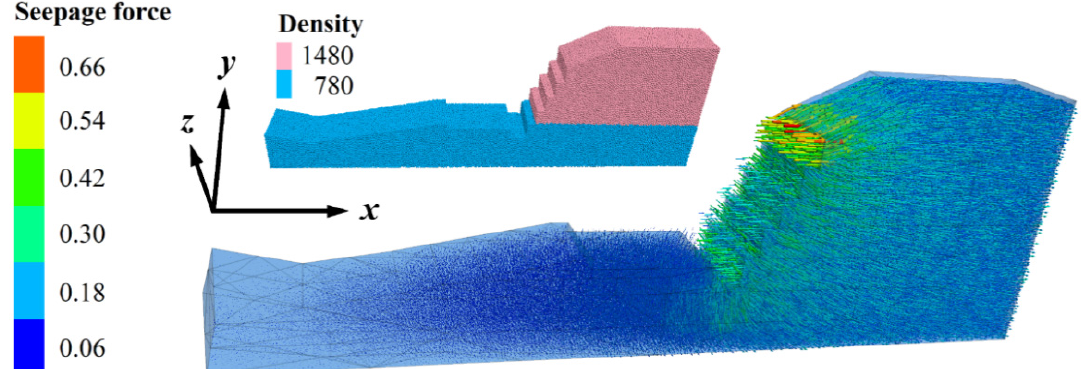
Figure 16. Seepage force and density distribution. The units of seepage force and density are N and kg/m 3 , respectively.